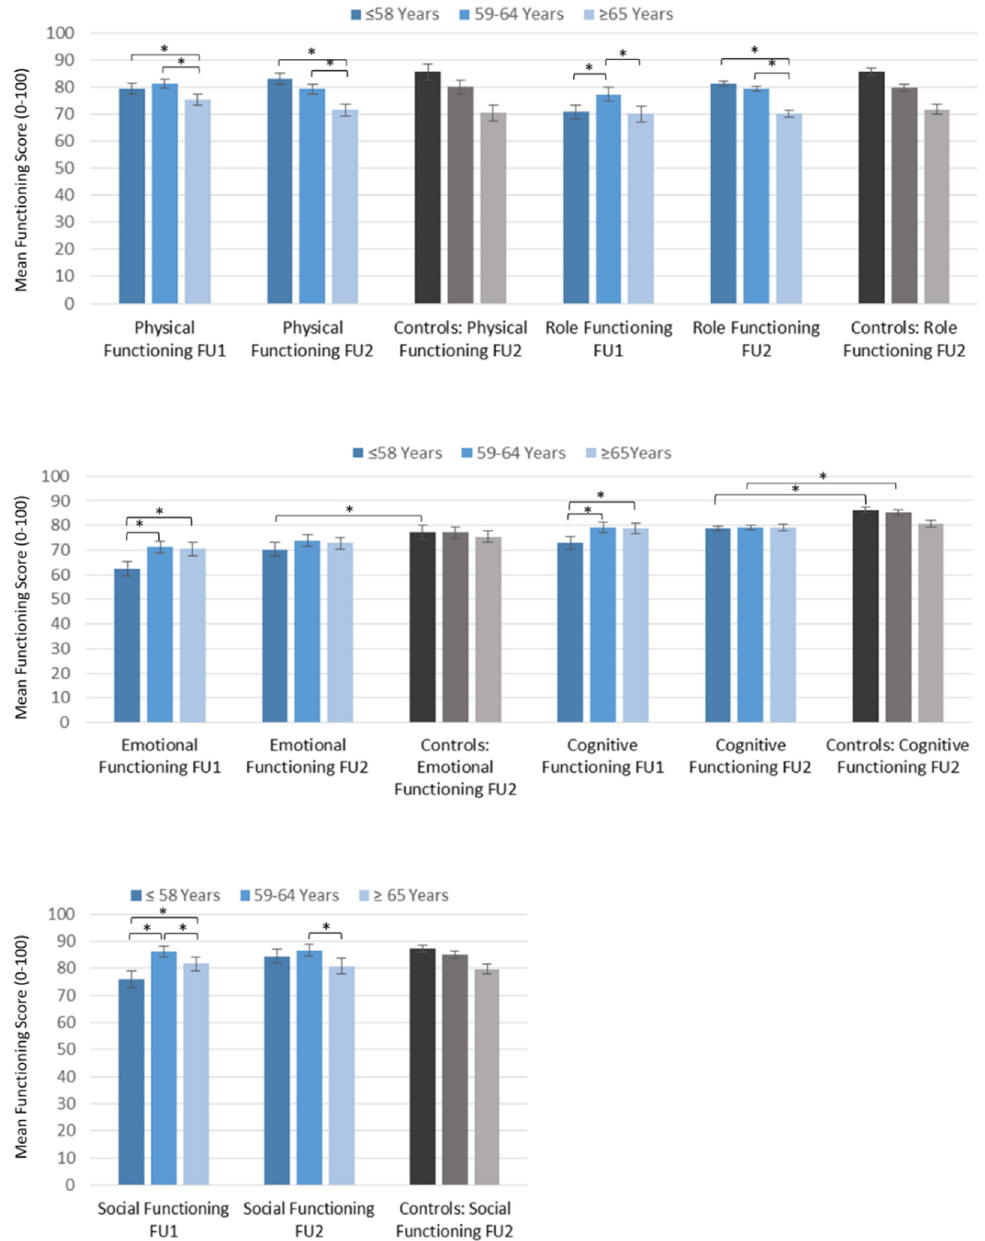
Figure 3. Functioning in breast cancer survivors at FU1 and FU2 stratified by age and compared to controls. Significant differences are indicated by an asterisk. Table 3. Functioning of breast cancer survivors at FU1 and FU2 stratified by age and compared to healthy controls at FU2.